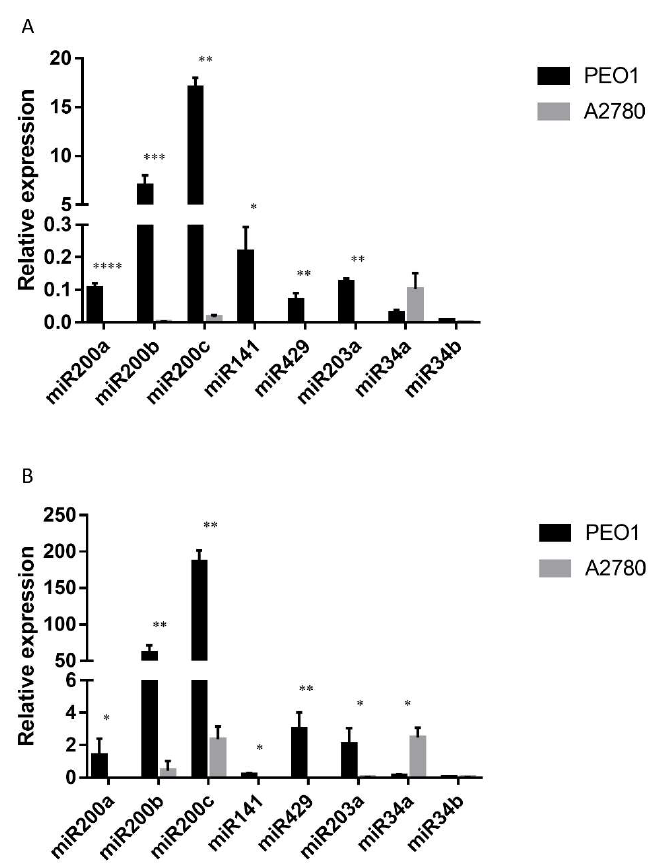
Figure 4. Relative expression level of miR200s, miR203a, miR34a and miR34b in the PEO1 and A2780 cell lines. Relative expression was determined using miR103 as reference. ( A ) Intracellular miRNA expression: MiRNA expression was detected in the cell lysates of non-treated cells. ( B ) Cell-free miRNA expression: MiRNAs were isolated from the supernatant of the cultures of non-treated cells. Data are presented as mean ± S.D. Significance was determined between the ∆ CT values of the PEO1 and A2780 cell lines: * p < 0.05; ** p < 0.01; *** p < 0.001; **** p < 0.0001.